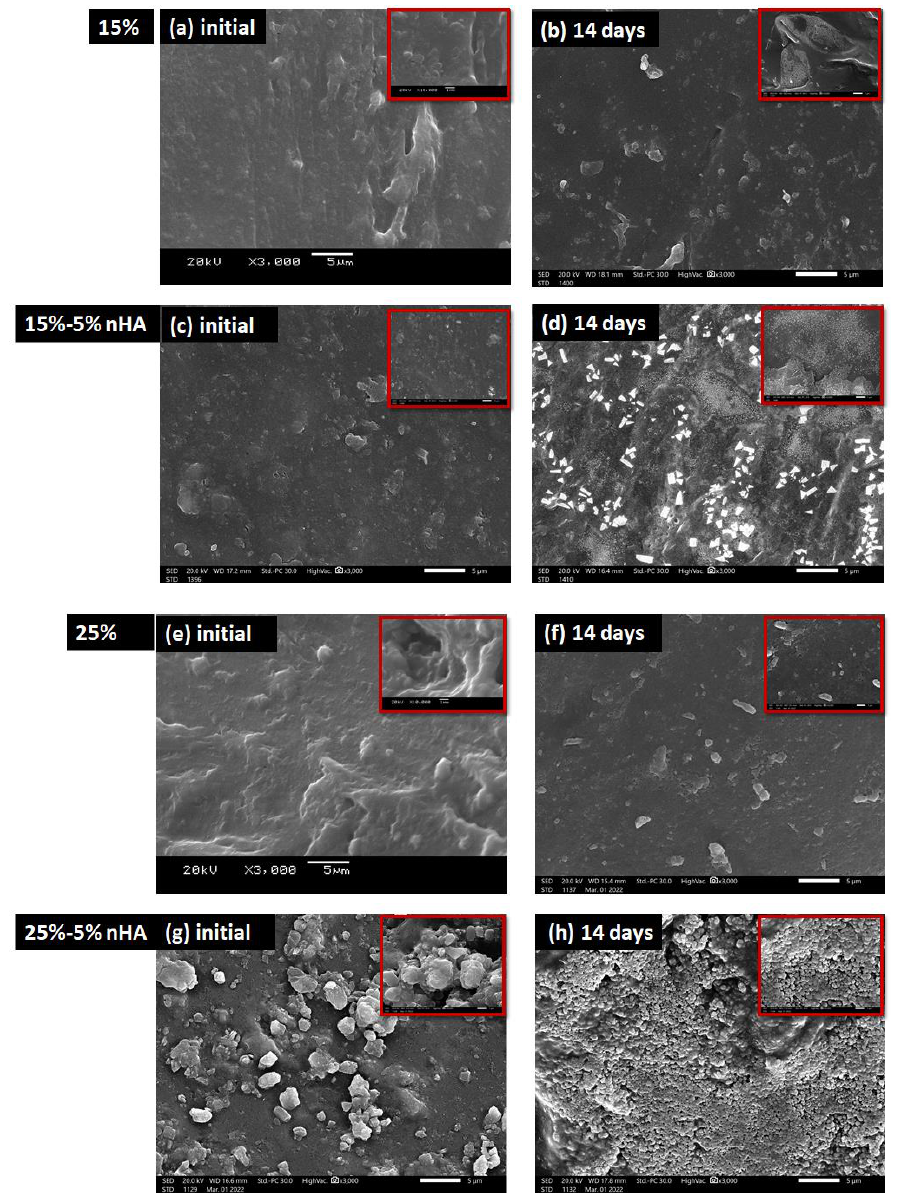
Figure 10. SEM images of the prepared nanocomposite hydrogels after 14 days of incubation in simulated body fluid (SBF): ( a ) 15% GA/chitosan/0% nHA initial hydrogel, ( b ) 15% GA/chitosan/0%